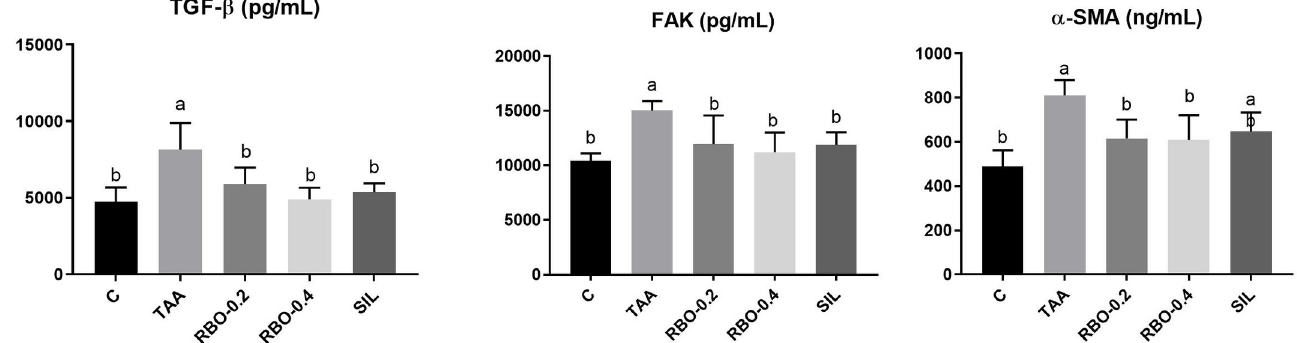
Fig 4. Effect of RBO on TGF- β 1, FAK and α -SMA in TAA-induced liver fibrosis in rats. Control rats, treated with saline; TAA rats, treated with thioacetamide (100 mg/kg; three times per week for 2 weeks, ip ); RBO rats, treated with TAA, RBO (0.2 and 0.4 mL/rat; daily for 2 weeks, po ) and silymarin (100 mg/kg, po ). All data are presented as Mean ± SEM, (n = 6). a P � 0.05 was assumed to denote statistical significance compared to the negative control, b P � 0.05 was assumed to denote statistical significance compared to TAA group. TAA, Thioacetamide; RBO, Rice bran oil; TGF- β 1, Transforming growth factor beta; FAK, Focal adhesion kinase; α -SMA, Alpha-Smooth Muscle